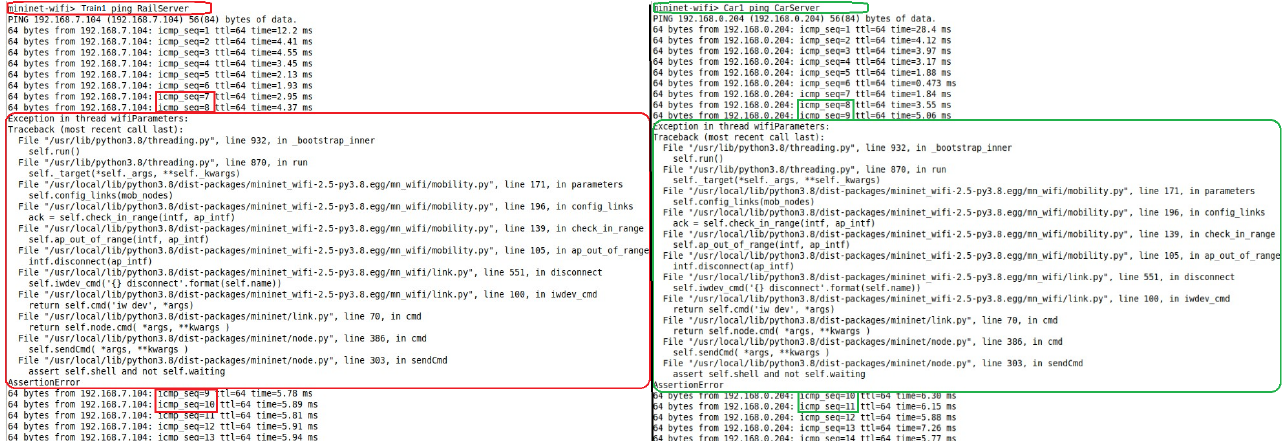
Figure 11. Checking connectivity during moving.